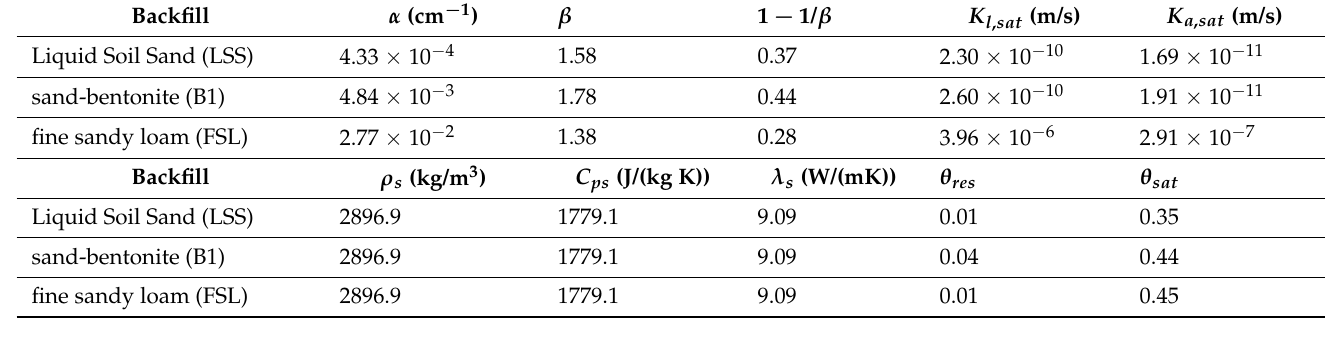
Table 9. Thermal and hydraulic properties of backfill materials (adopted from [39–41]).